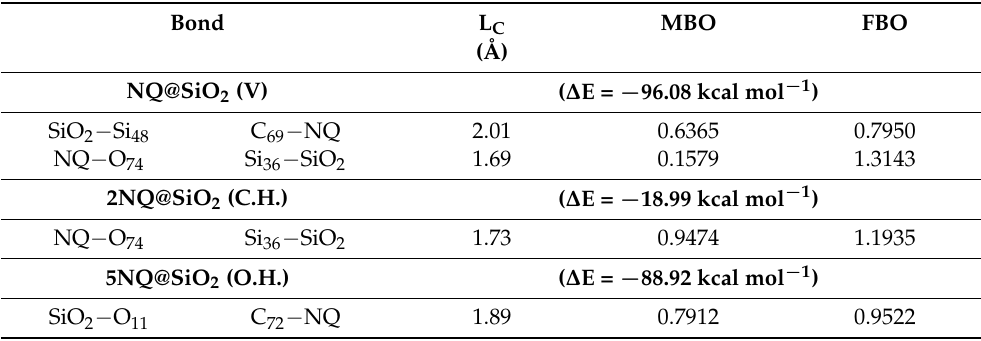
Figure 8. NQs@SiO 2 interaction molecular models. ( A ) Horizontal (H) and ( B ) vertical (V) interactions of NQ; ( C ) closed horizontal (C.H.) and ( D ) open horizontal (O.H.) configuration of 2NQ; ( E ) closed horizontal (C.H.) and ( F ) open horizontal (O.H.) configuration of 5NQ. Black labels are the bond critical point (BCP) indices. Yellow lines correspond to bond paths. Table 4. Interaction energy ( Δ𝐸 ), length of covalent bond (L C ), Mayer bond order (MBO), and fuzzy bond order (FBO) values obtained from interaction models.